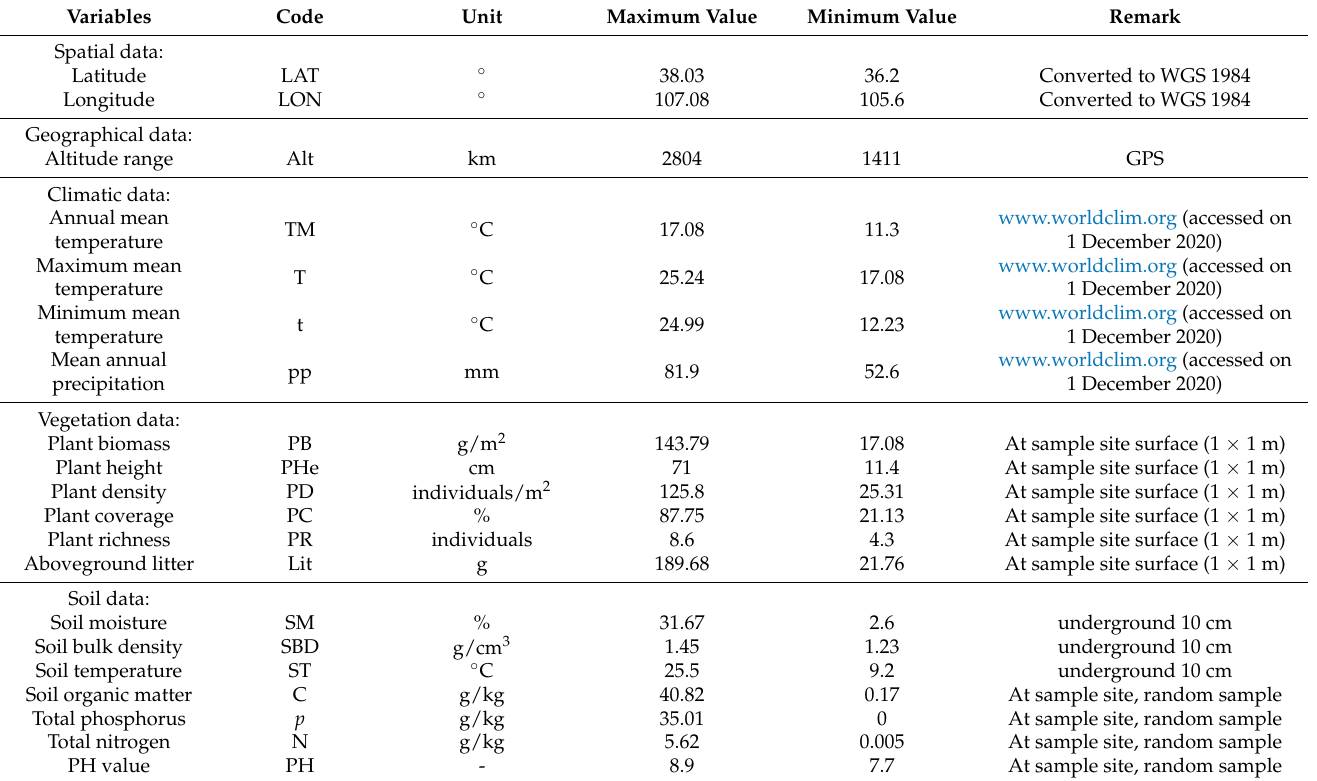
Table A2. Summary of variables data collected in the study area.